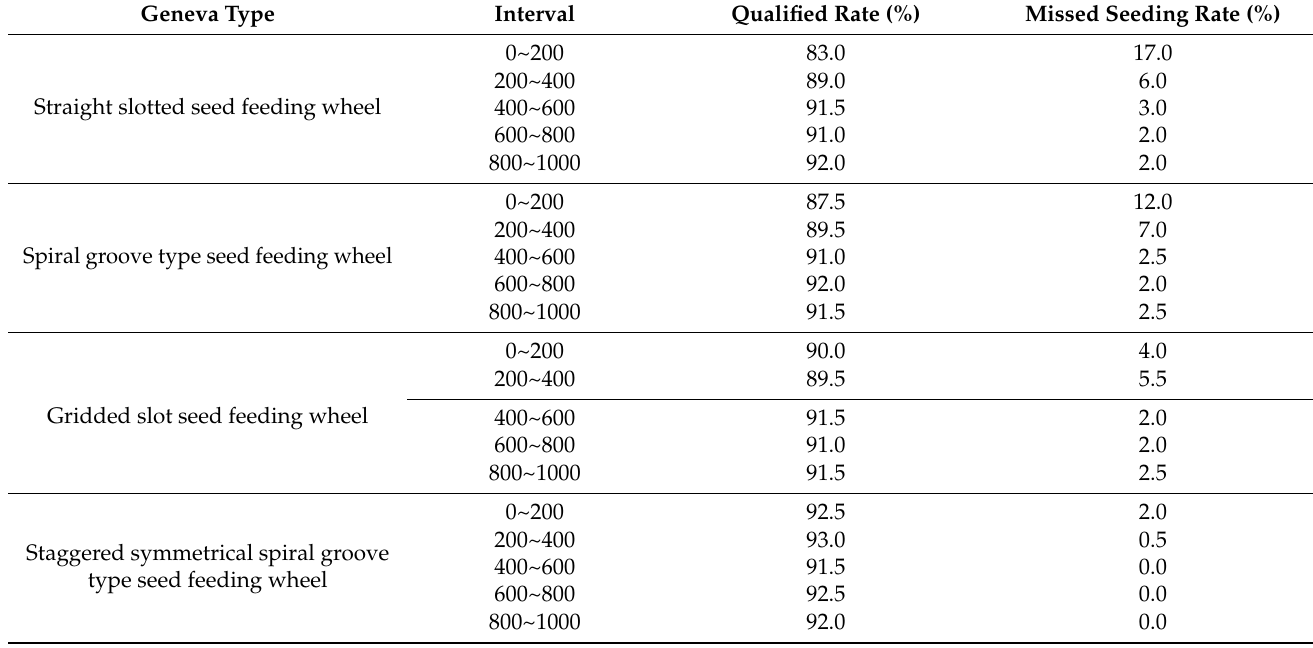
Table 5. Effect of groove wheel structure on seeding